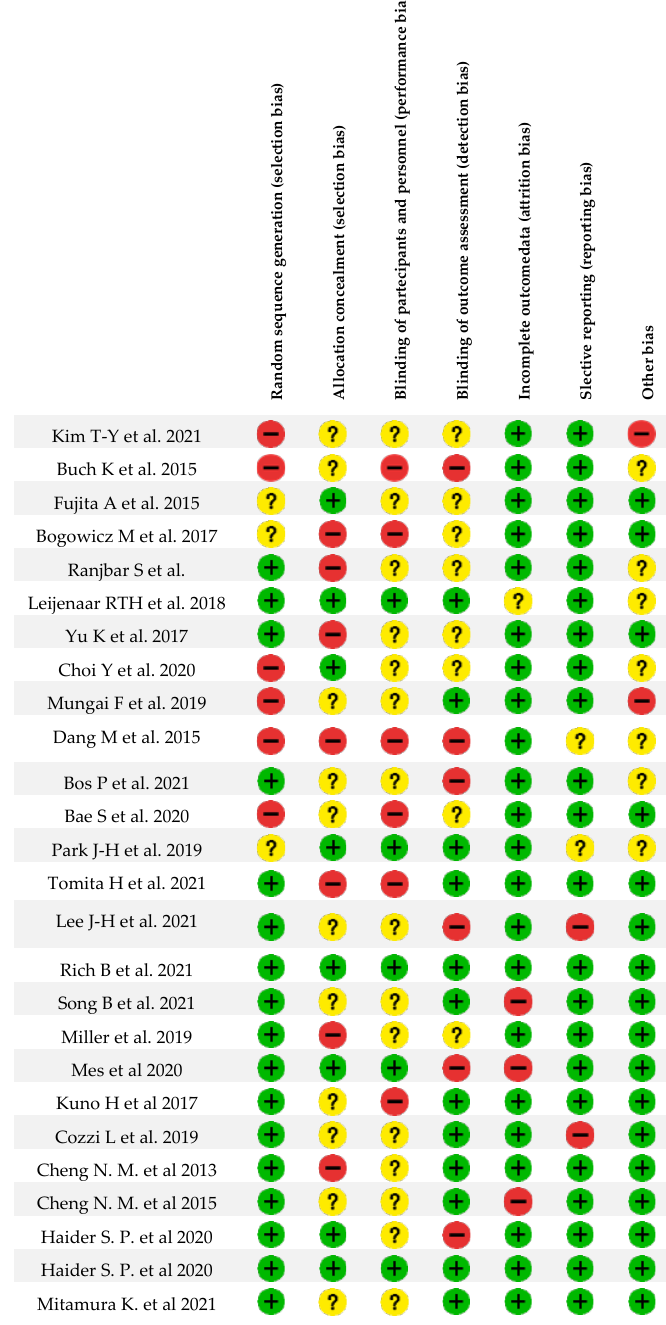
Figure A2. Risk of bias assessment for individual papers [19,41 – 65].